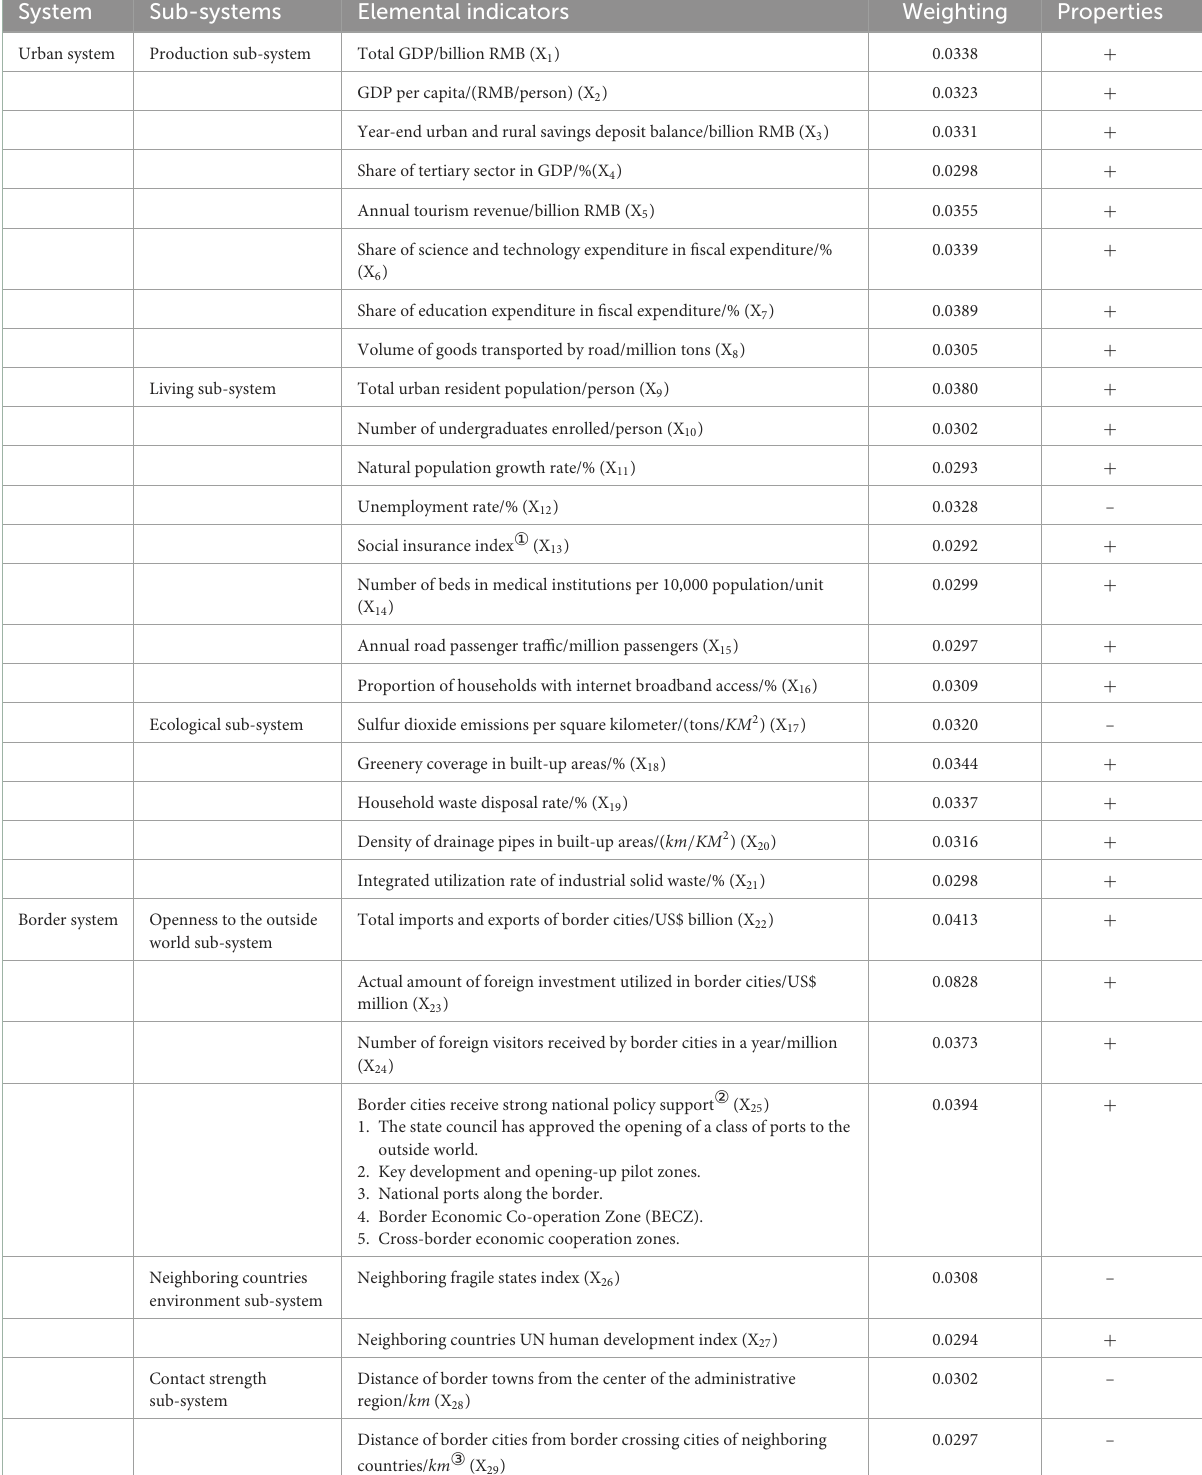
TABLE 2 Evaluation index system of border city